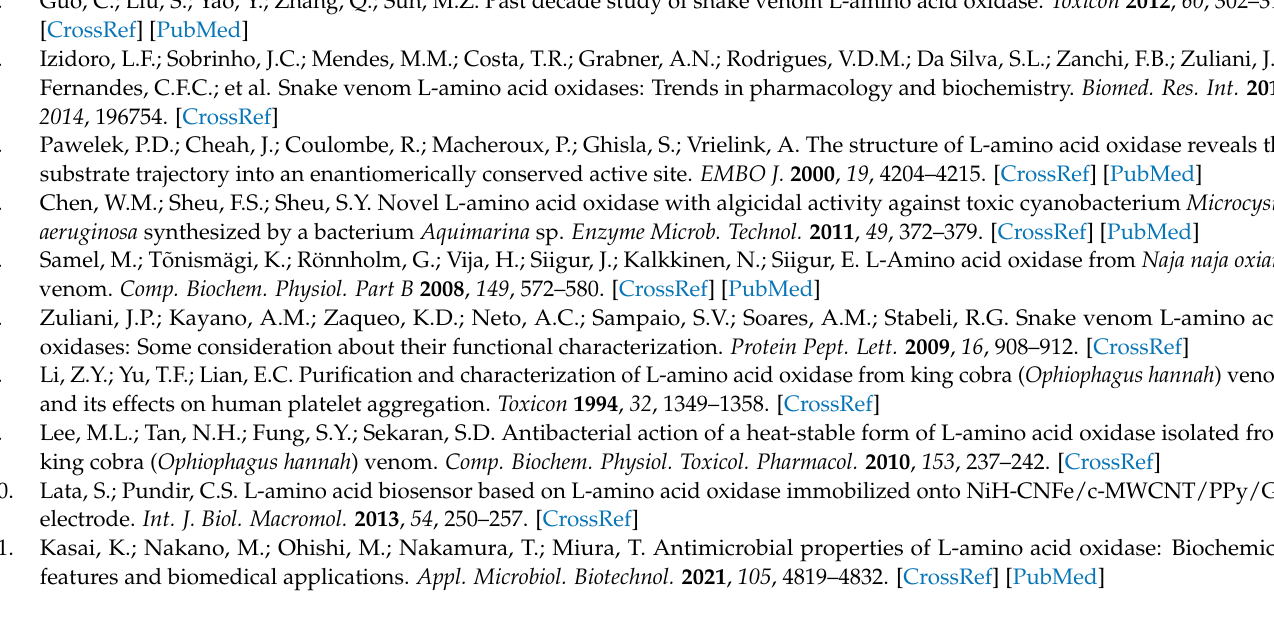
incubation at 37 ◦ C over time. For the last two figures, data are shown for samples in low salt buffer (blue line) and in high salt buffer (orange line) as comparison. Figure S5: Steady state kinetics for 18 of the 20 proteinogenic amino acids. All measurements were performed in duplicate. No activity was observed for proline and cysteine. Figure S6: Top, sequence alignment between Pl -LAAO and the homologue from ancestral sequence reconstruction, the structure of which is deposited under the PDB 7C4K. Non-conserved sites are highlighted by black bars. Bottom, the structure of 7C4K with non-conserved sites in dark blue. All of these are limited to surface-exposed portions of the protein, while the active site and the cofactor binding residues are fully retained. For sake of clarity, the portions with highest divergence are reported in rectangles of the same colour in both sequence alignment and structure representation. Figure S7: Focus on the electron density (in blue chicken wire) of FAD (in yellow carbons) and glycerol (in green carbons) present only in molecule B of the asymmetric unit. Figure S8: (a) Structure of LAAO with the tunnel (magenta) leading from the FAD cofactor to the solvent-accessible surface. (b) Side view of the tunnel, the entrance of which is enclosed in the black circle. A set of side chains, the motion of which is necessary to allow access to the active site, is highlighted. (c) A 180 ◦ rotated view of the same side view. Table S1: Crystallographic data collection and refinement statistics. The values for the high-resolution shell are shown in